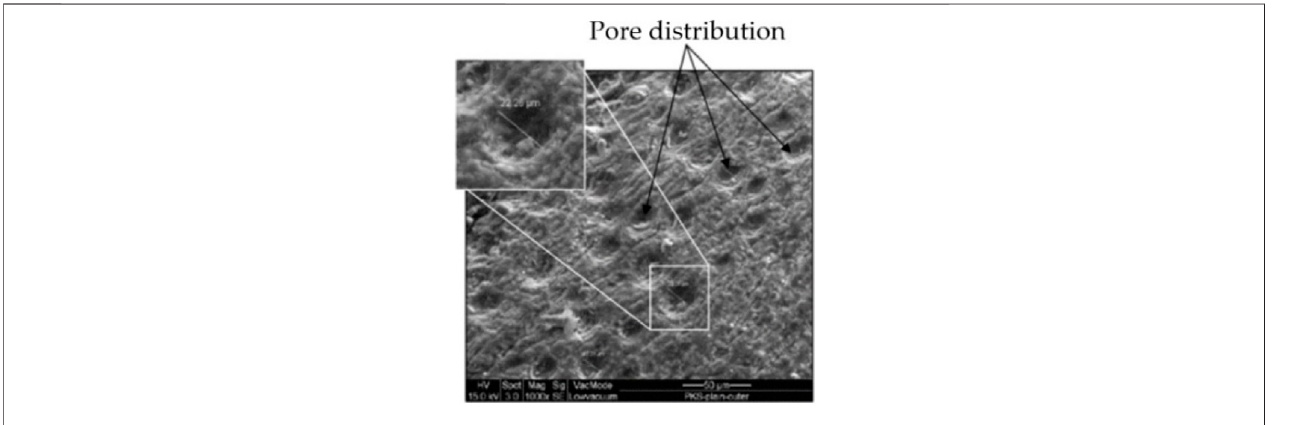
FIGURE 11 | Micro-pores on outer surface (Alengaram et al.,